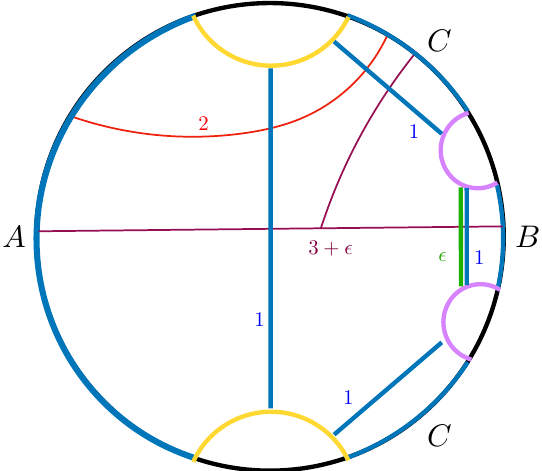
Figure 10 . A 3-boundary wormhole constructed by identifying geodesics (the yellow and purple pairs) of a constant time slice of AdS . Using the methods described above we find that the 3 maximum number of 3-threads is given by the smallest entanglement entropy of the three boundary regions. Here we take it to be S ( B ) . In fact a configuration of 2 and 3 -threads which saturates m 2 can be found such that we have the maximum possible 3-threads i.e. t = m = m . Unlike in 3 3 B the case of vacuum AdS, since the entanglement entropy is finite the contribution of 2-threads and k -threads can be chosen to be of comparable